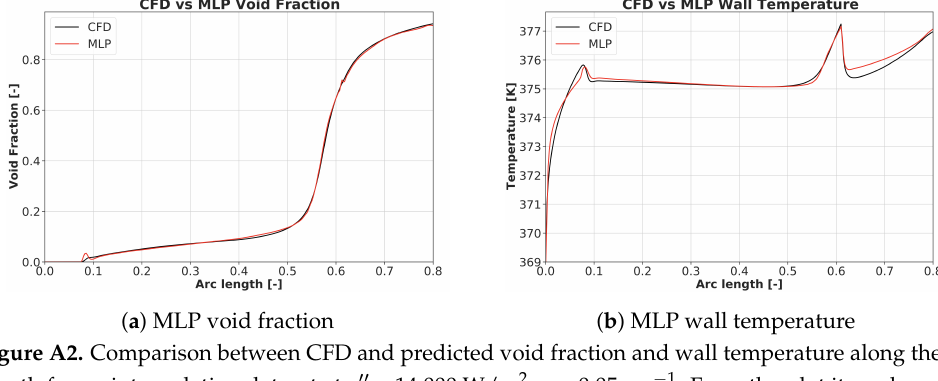
Figure A2. Comparison between CFD and predicted void fraction and wall temperature along the arc length for an interpolation dataset at q (cid:48)(cid:48) = 14,000 W/m 2 , u = 0.05 ms − 1 . From the plot it can be noted that the MLP model has some artefacts while predicting the void fraction. It showed a sharp jump in void fraction around 0.8 arc length where the nucleation starts in the minichannel.